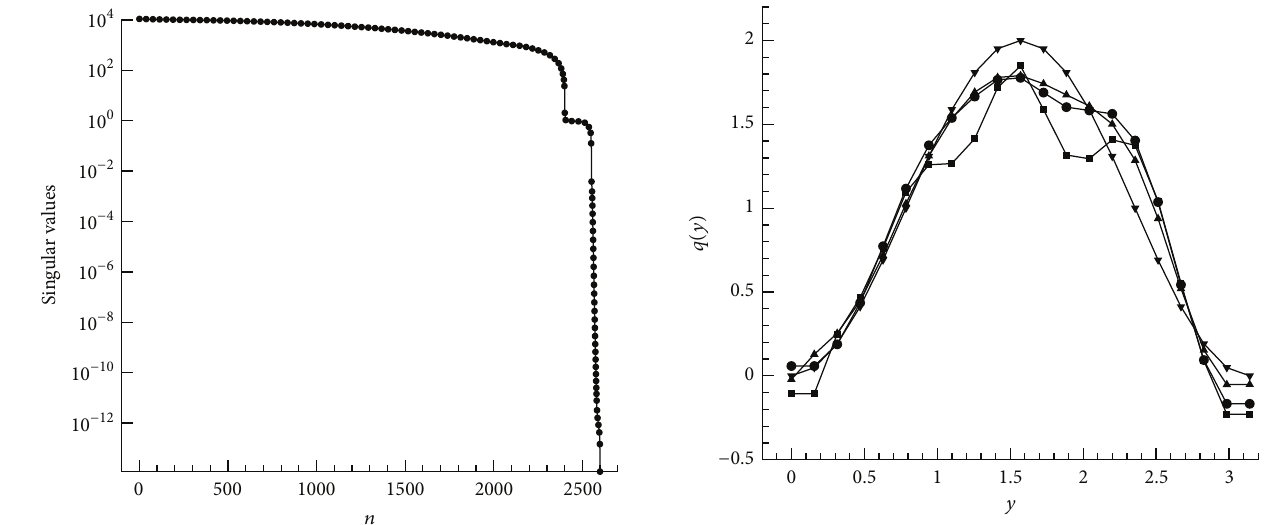
Figure 4: Singular values of matrix 𝐴 for 𝑁 = 50 .